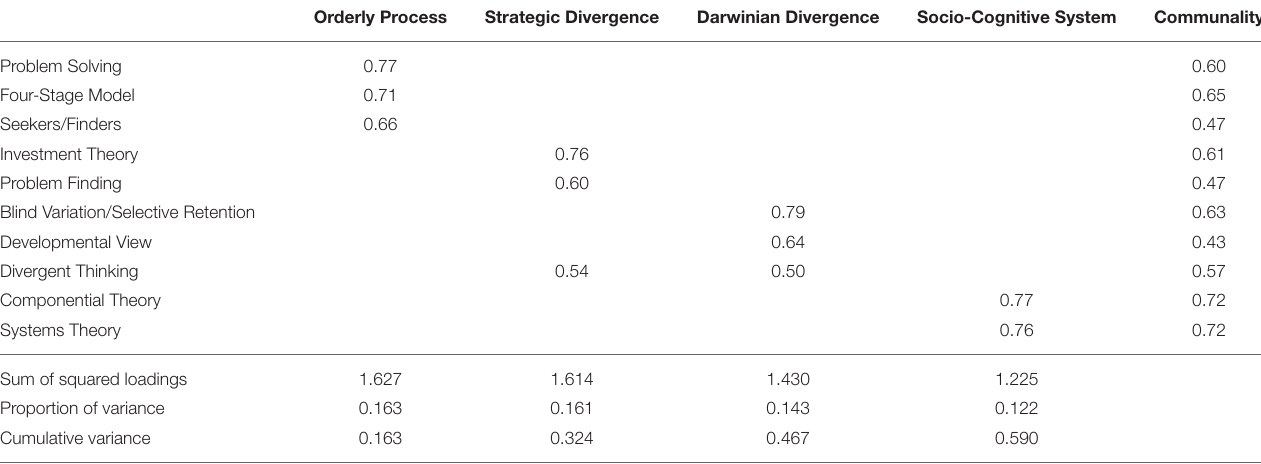
TABLE 1 | Principal component analysis of participants’ ratings for the 10 theories (with varimax rotation).